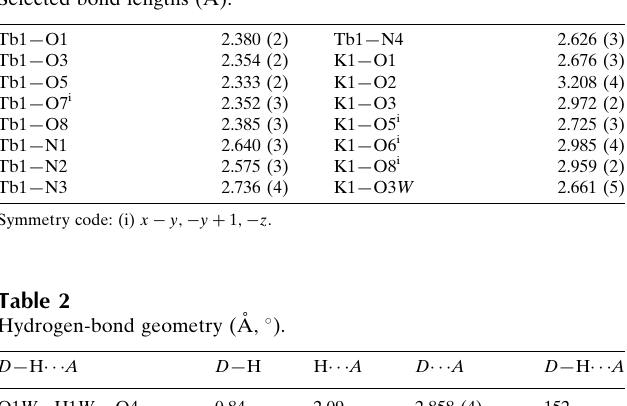
Selected bond lengths (A˚ ).